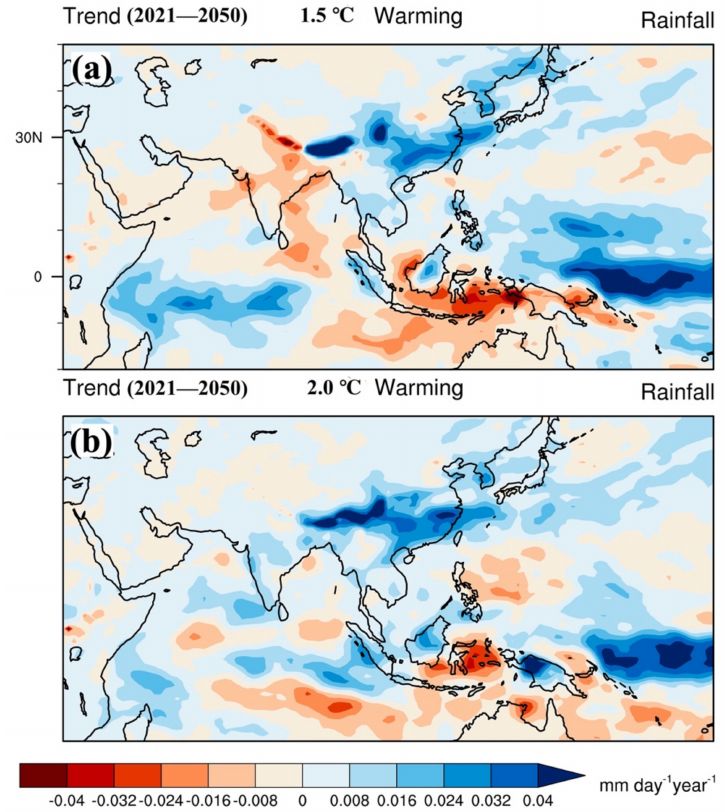
Figure 1. Ensemble JJAS trend (2021–2050) of precipitation (mm day − 1 year − 1 ) under ( a ) 1.5 ◦ C and ( b ) 2.0 ◦ C warming